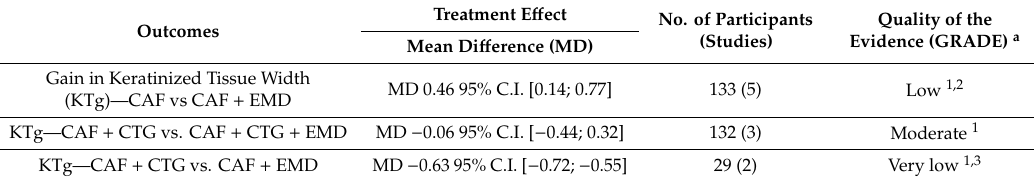
Table 3. Summary of findings with the GRADE